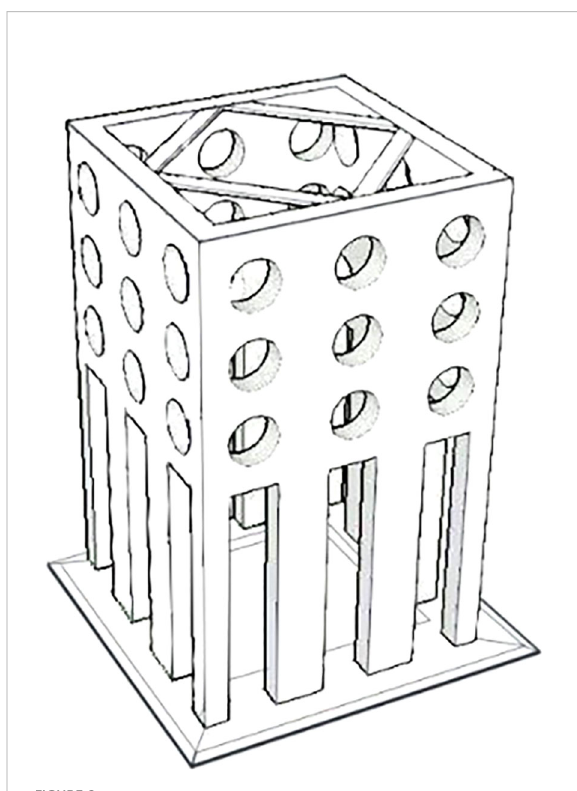
FIGURE 2 Types of ARs (3.6 m×3.6 m×5.5 m) from which attached organisms were